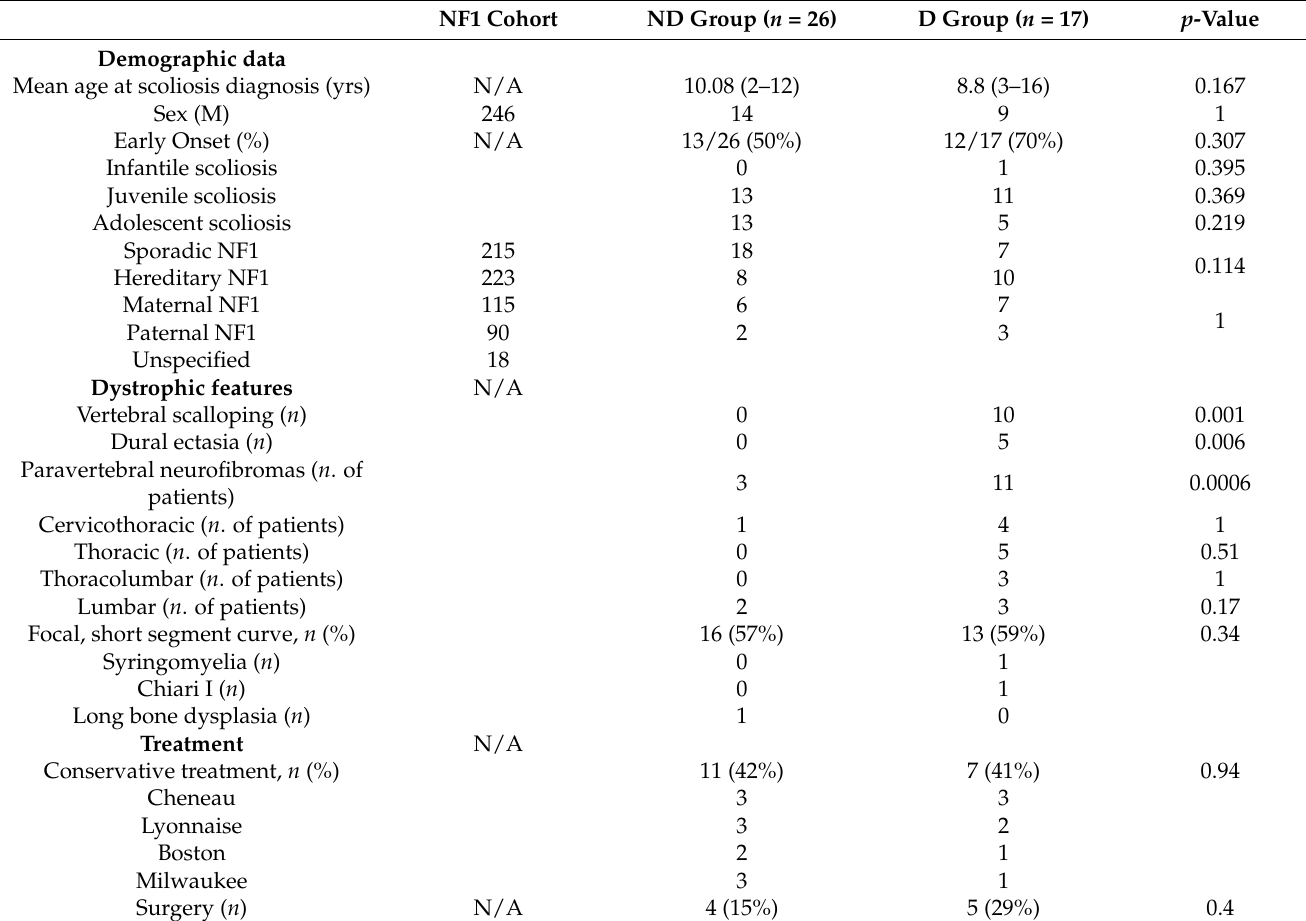
Table 2. Characteristics of the two study groups. ND: non-dystrophic D: